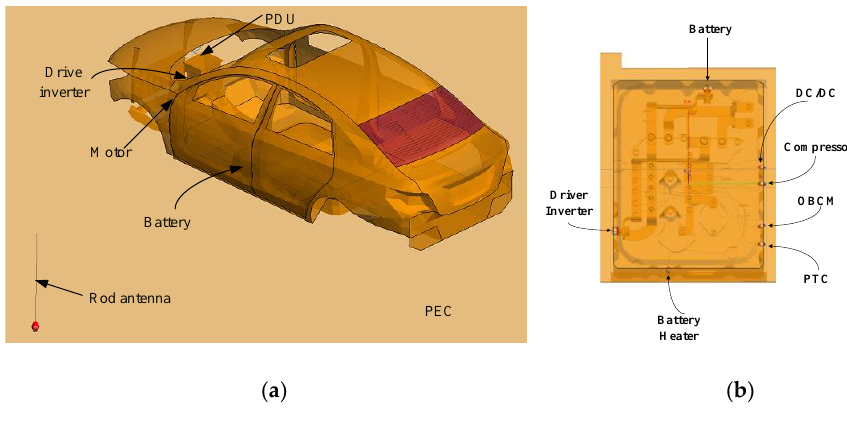
Figure 8. Simulation model in FEKO: ( a ) EV model; ( b ) PDU model.